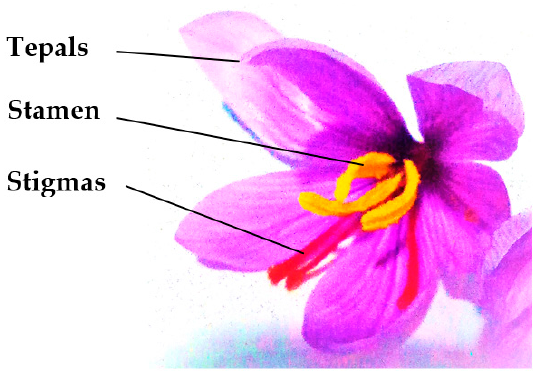
Figure 1. Structure of Crocus sativus flower (original authors’ picture).